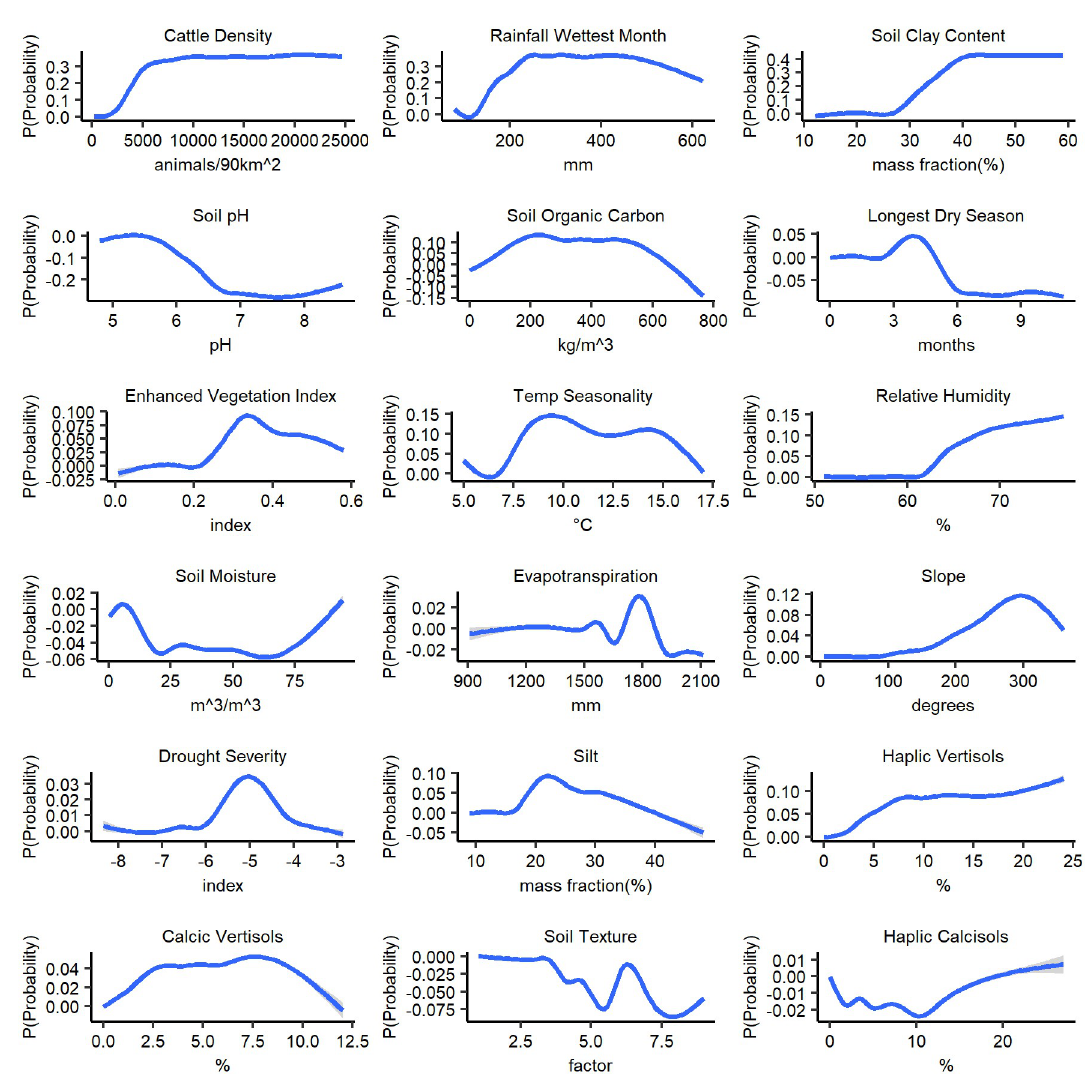
Fig 5. Partial dependency plots (PDP) showing marginal effects on the mean prediction probability of potential anthrax distribution by each variable across the 100 BRT